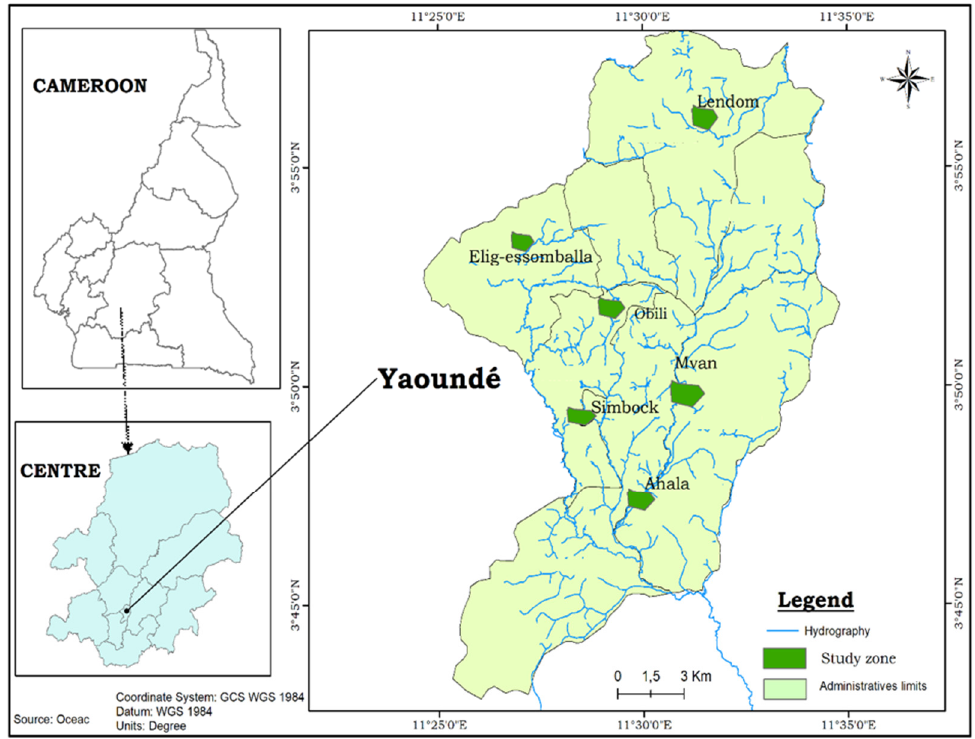
Figure 1. Map of the city of Yaoundé showing the study